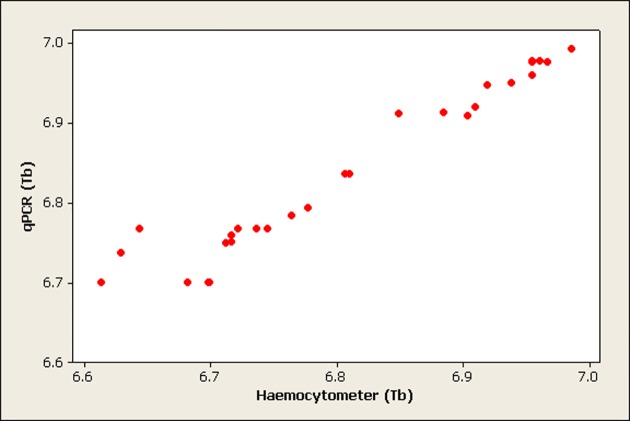
Scatterplot showing the correlation between qPCR and haemocytometer quantification of T. b. brucei (Tb) in midguts (numbers are presented on log 10 scale and each dot is the average of three replicates).